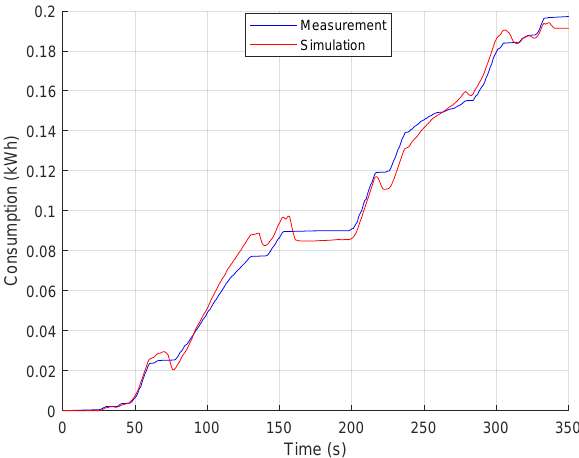
Figure 16. Comparison of real and simulated consumption of the Biro.